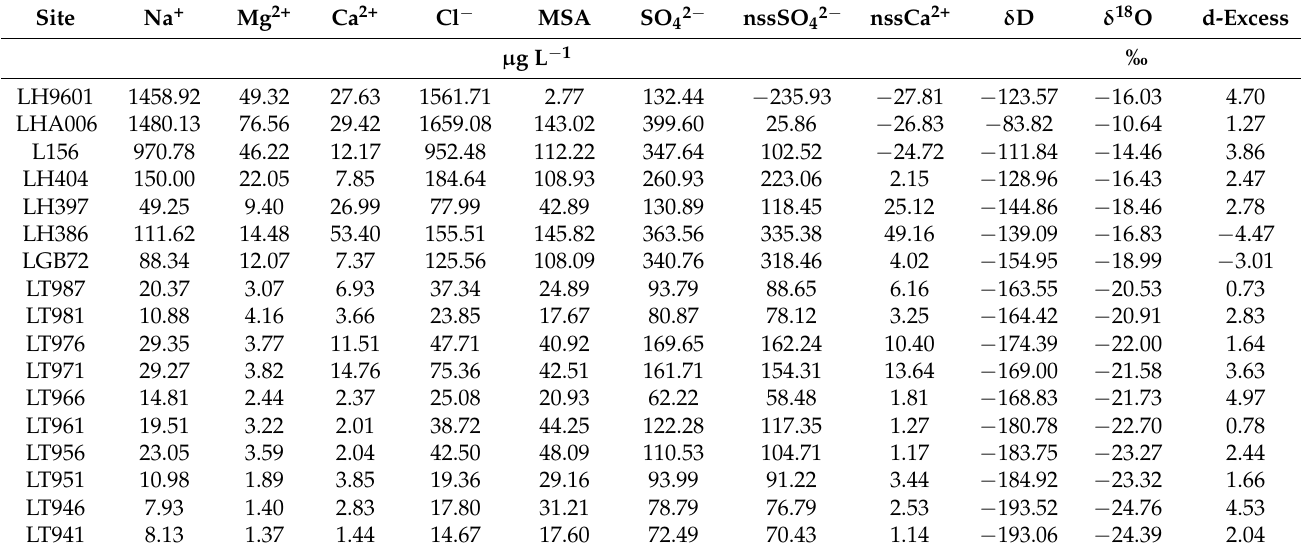
Table 3. Concentrations of major ions and values of stable isotopes of the surface snow samples from coast to inland. Site Na +